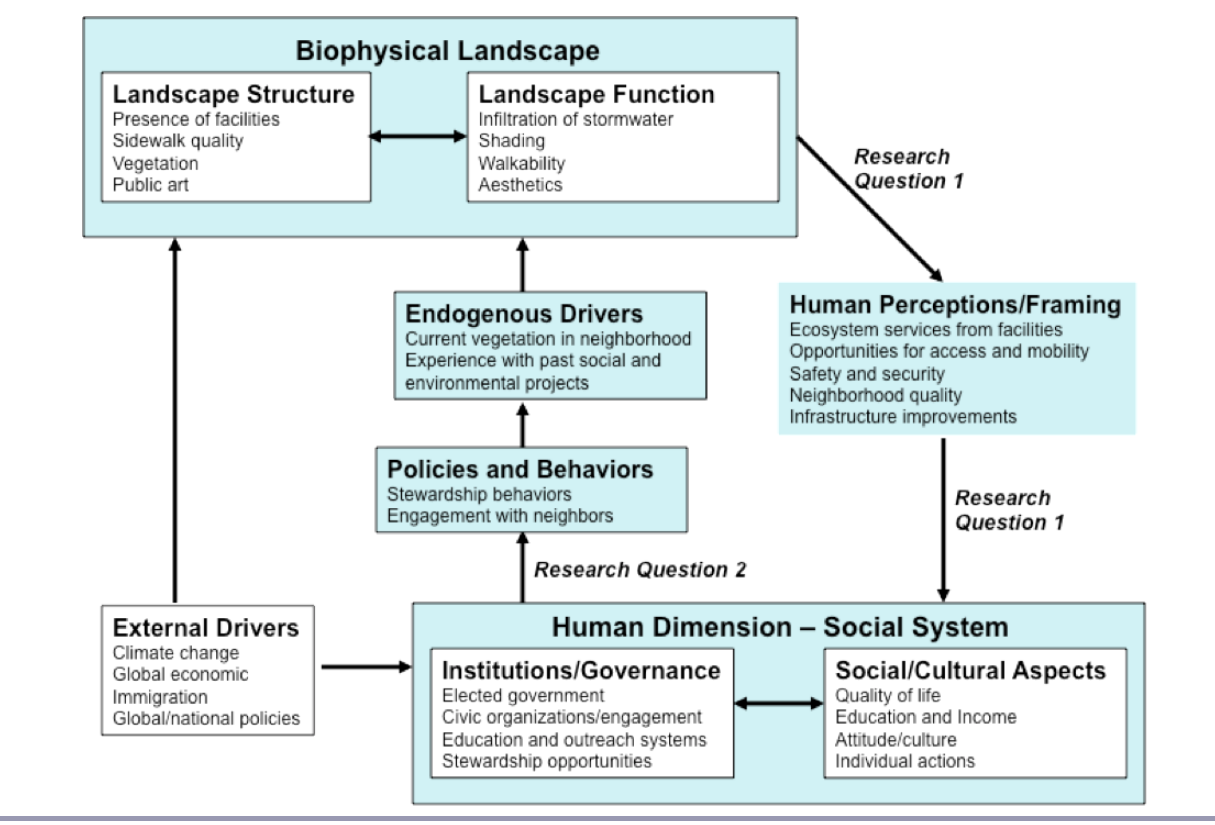
Fig. 1. Conceptual model coupling the biophysical landscape with the human and social system. Adapted from Shandas et al.